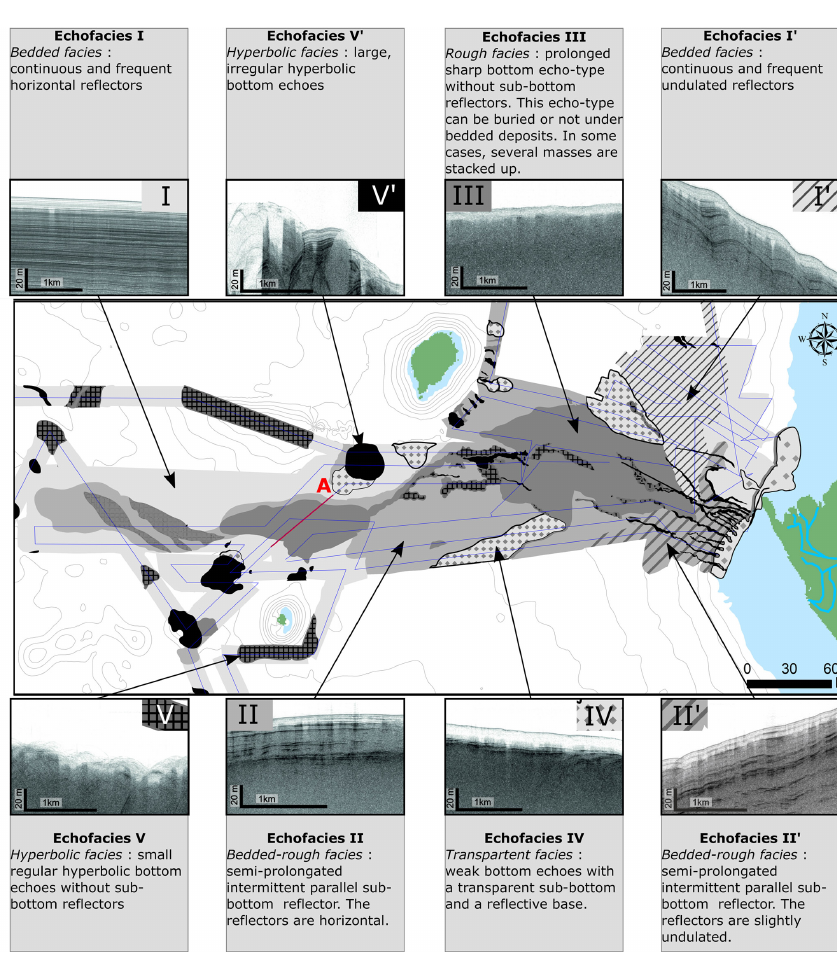
Figure 11. Echofacies map of the Ogooue Fan. Eight shades of grey represent the specific echofacies.